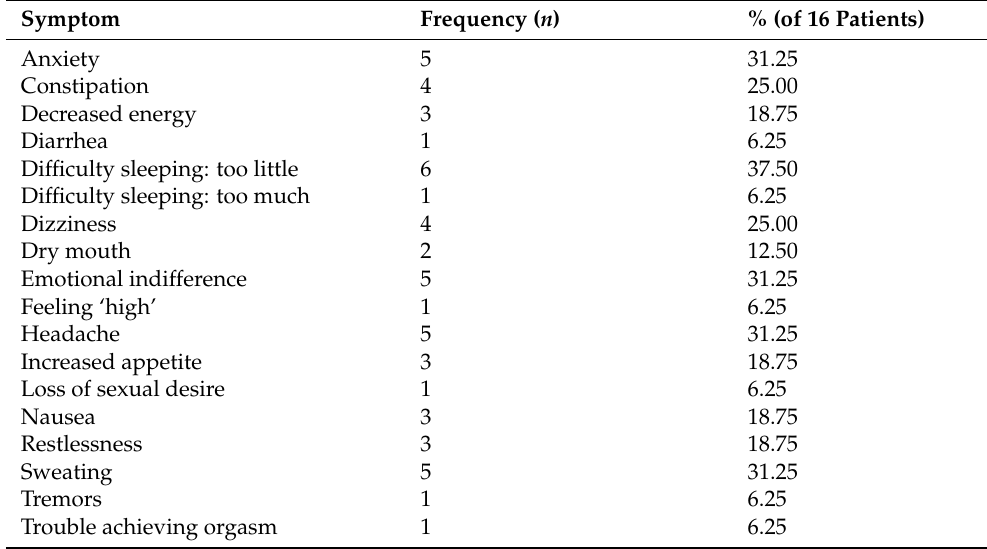
Table 2. Adverse events: symptoms reported as new or worsening from baseline during the infusion and/or within the subsequent 24 h